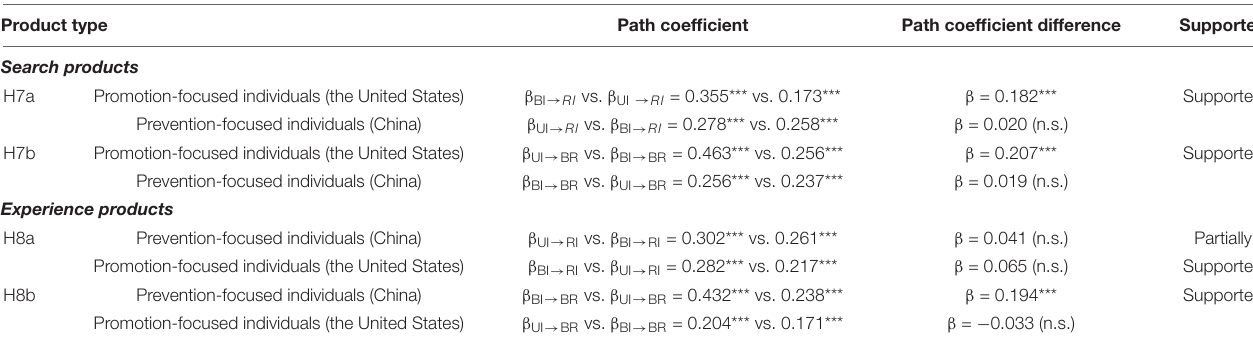
TABLE 8 | Analytic results of the moderating effects of product